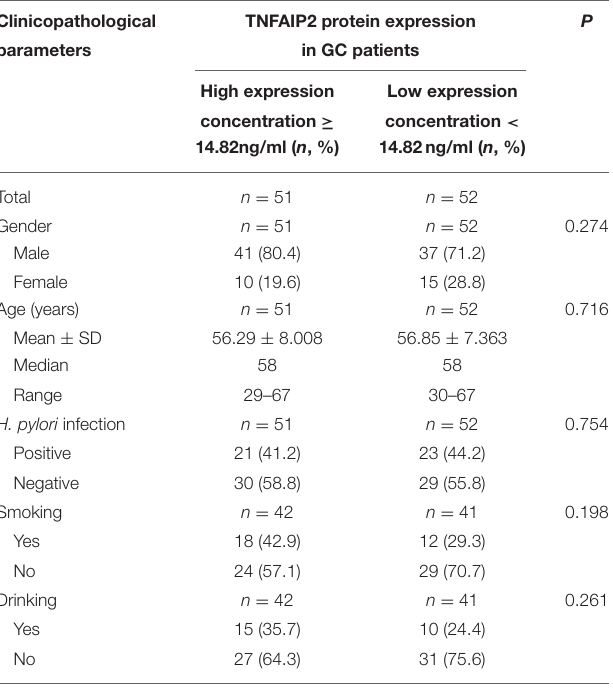
TABLE 9 | The correlation between serum TNFAIP2 protein expression and clinicopathological parameters in gastric cancer (GC) patients. Clinicopathological